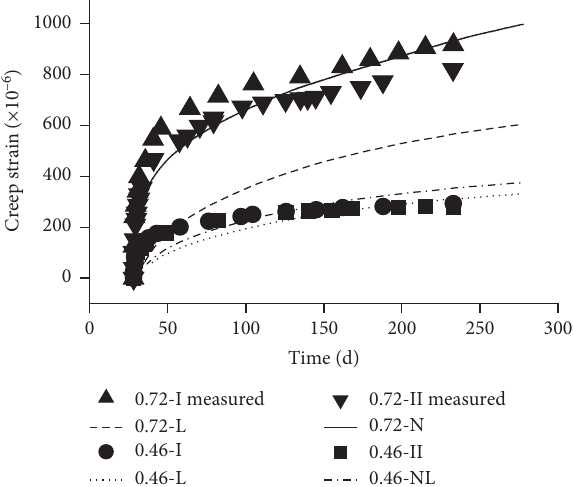
Figure 7: Calculated concrete creep strain curve (Fu [6]).